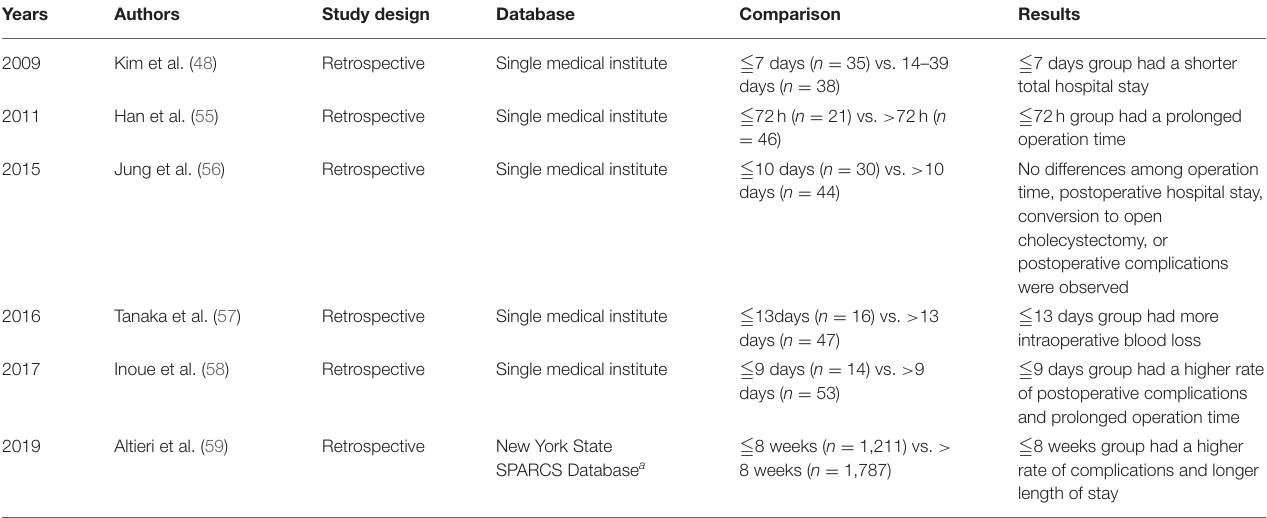
TABLE 1 | Summary of literature reviews on PC followed by